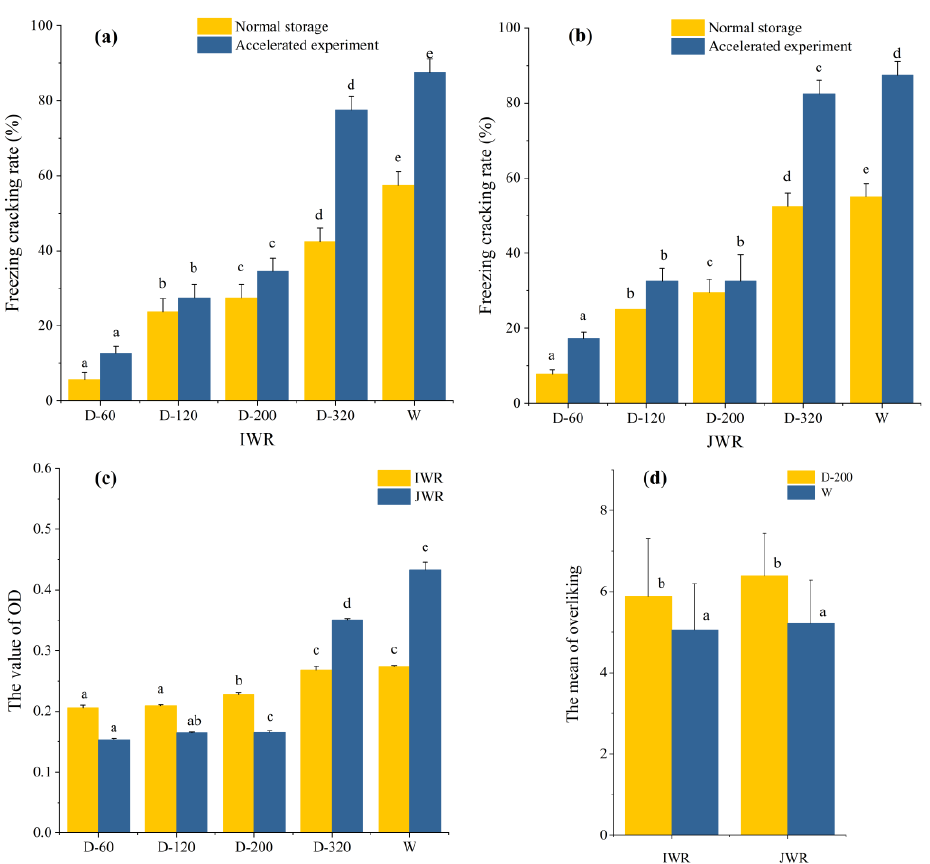
Figure 5. The indicators of waxy rice balls. ( a , b ) stand for the freezing cracking rate of waxy rice balls in IWR and JWR, respectively; ( c ) stands for the value of OD, the OD value was the absorbance of samples’ soup at 620 nm; ( d ) stands for the mean of overall liking in consumer tests. Different letters within a column indicate significant differences between mean values ( p < 0.05)